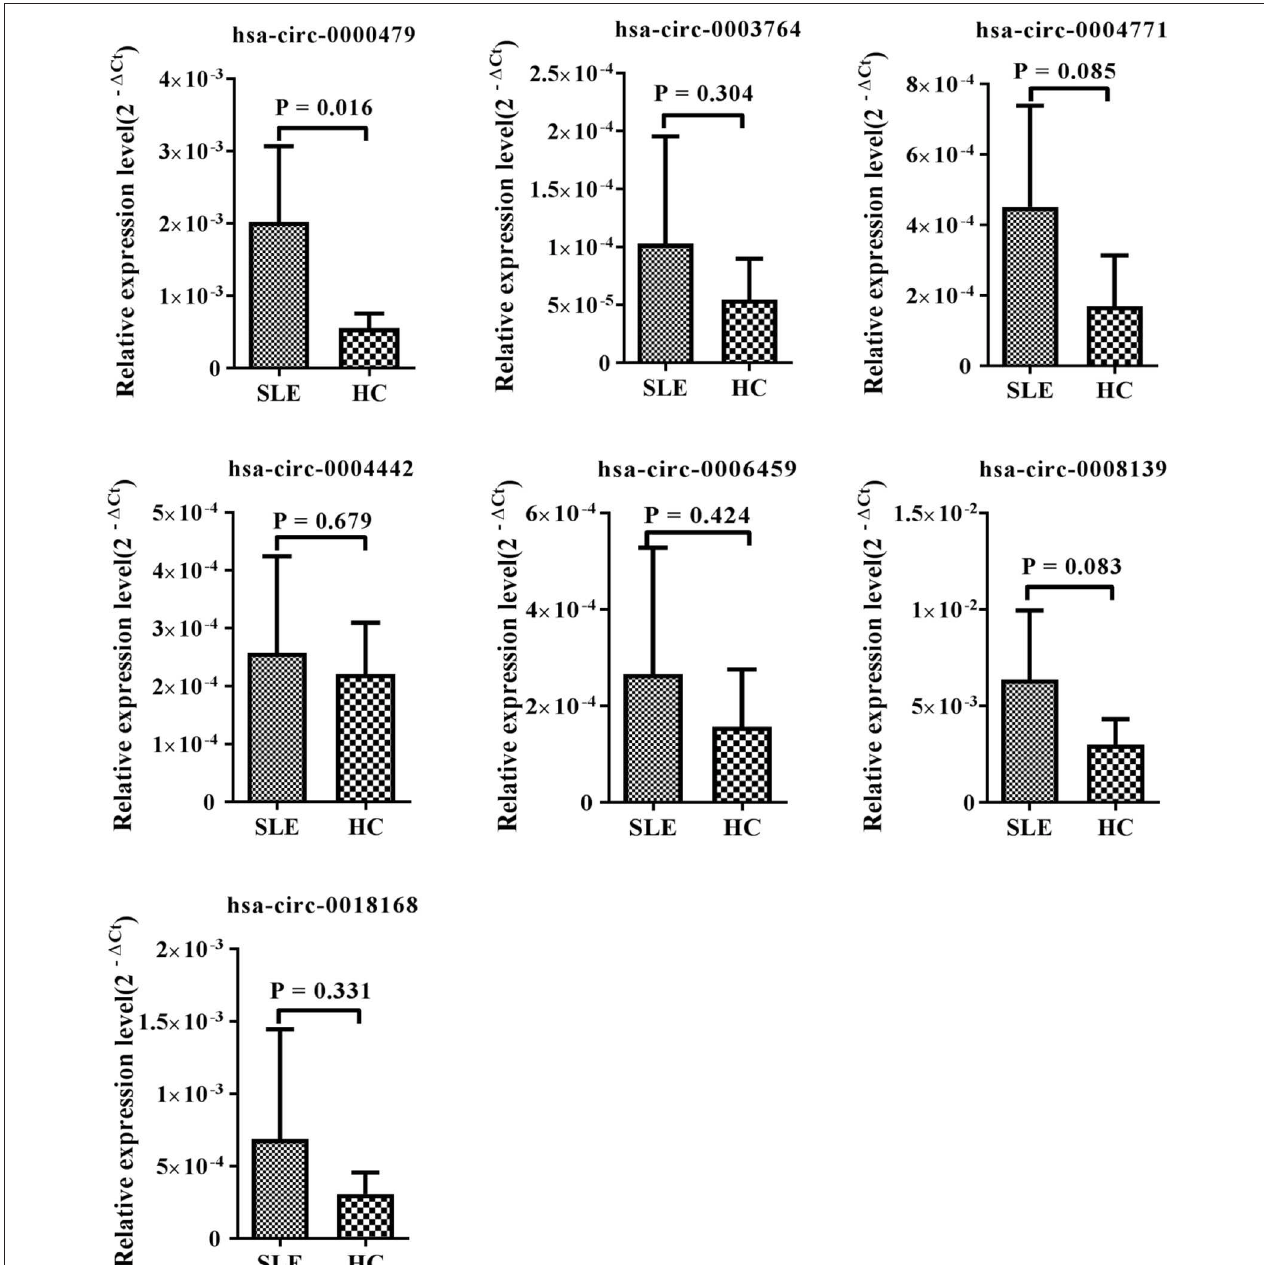
FIGURE 3 | Expression of candidate circRNAs in PBMCs of SLE patients and healthy controls. The expression trends of seven circRNAs was consistent with the NGS profile results. qRT-PCR was conducted on RNA samples from five SLE patients and five HCs. Data are presented as 2 − 1 Ct relative to GAPDH expression (mean ± standard